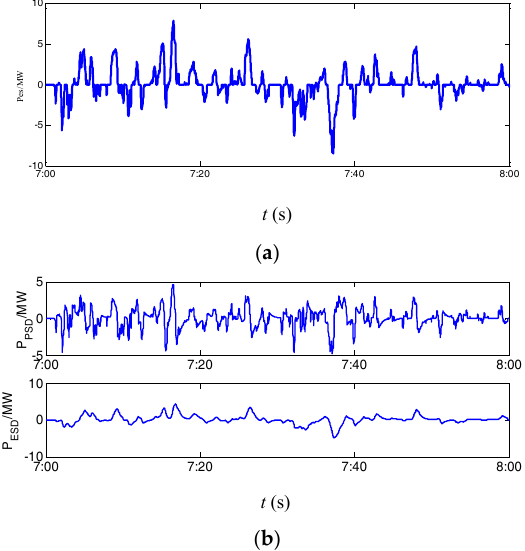
Figure 6. ( a ) Wind farm output power smoothed by MPC and LFA respectively; ( b ) Power fluctuation γ ) and with ( γ ) smooth control ratio without ( 1 2 P is given in Figure 7a with MPC control. Through The total energy storage power needed of es P (ESD power) are allocated automatically, as shown in Figure 7b. ESD